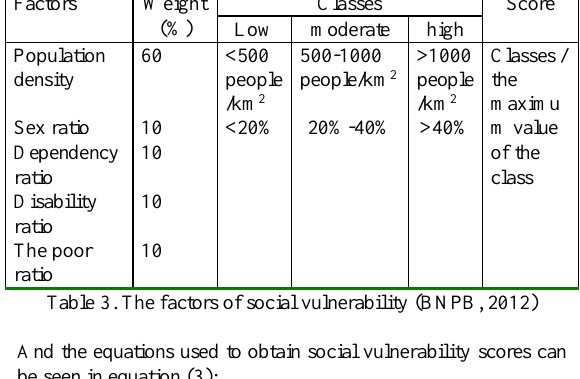
Figure 3. Automated classification